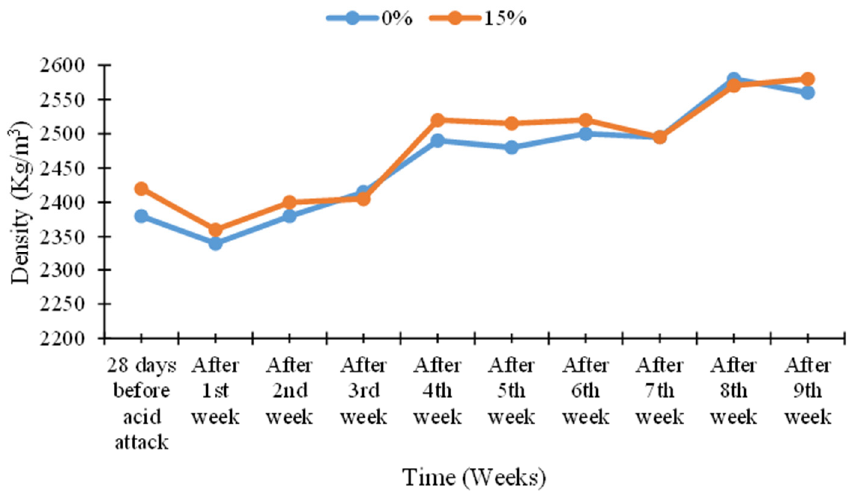
Figure 20. Comparison of density versus time curves for 0% (control) and 10% MK contents.